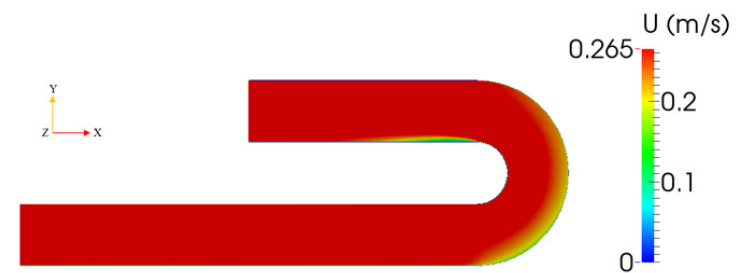
Figure 7. The distribution of water surface velocity (Realizable k- ε ).